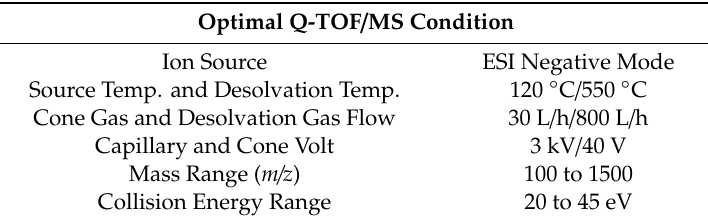
Table 2. Optimal conditions for Q-TOF / MS analysis of